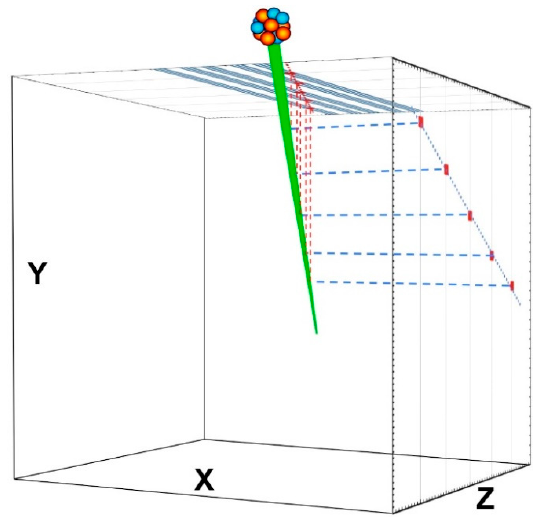
Figure 20. Sketch of the 3D track reconstruction for the data of Figure 19.